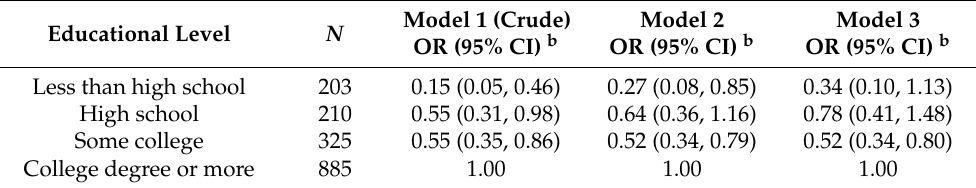
Table 2. Association between educational level and ideal CVH a in Asian Americans, NHANES, 2011–2016 (n =